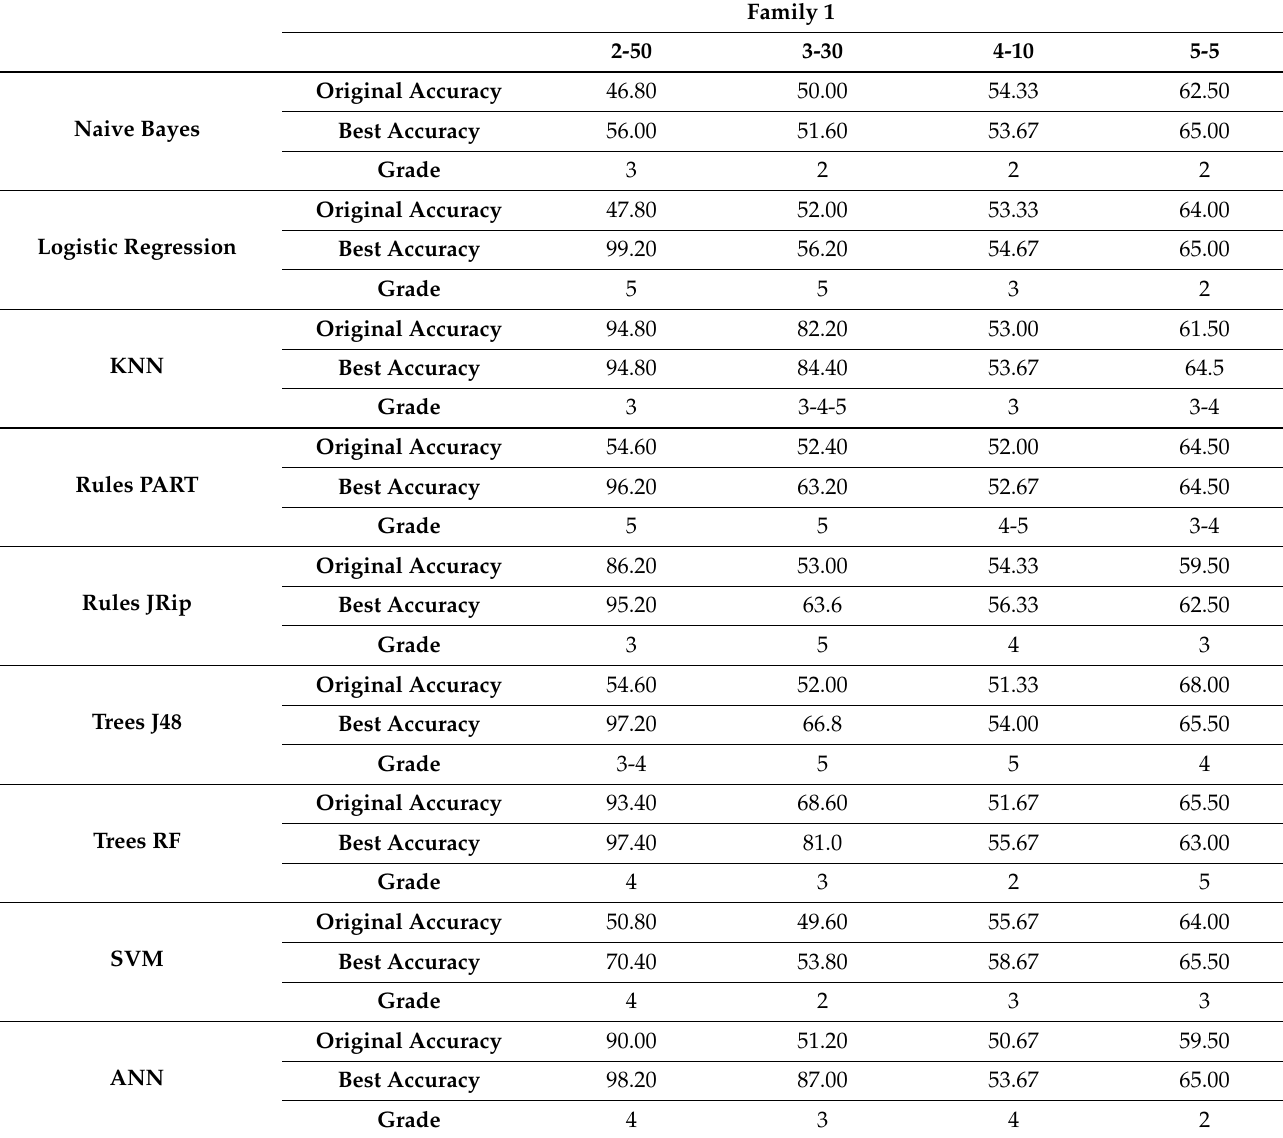
Table 4. Results of artificial data from Family 1, where we only show the accuracy for the best values of k